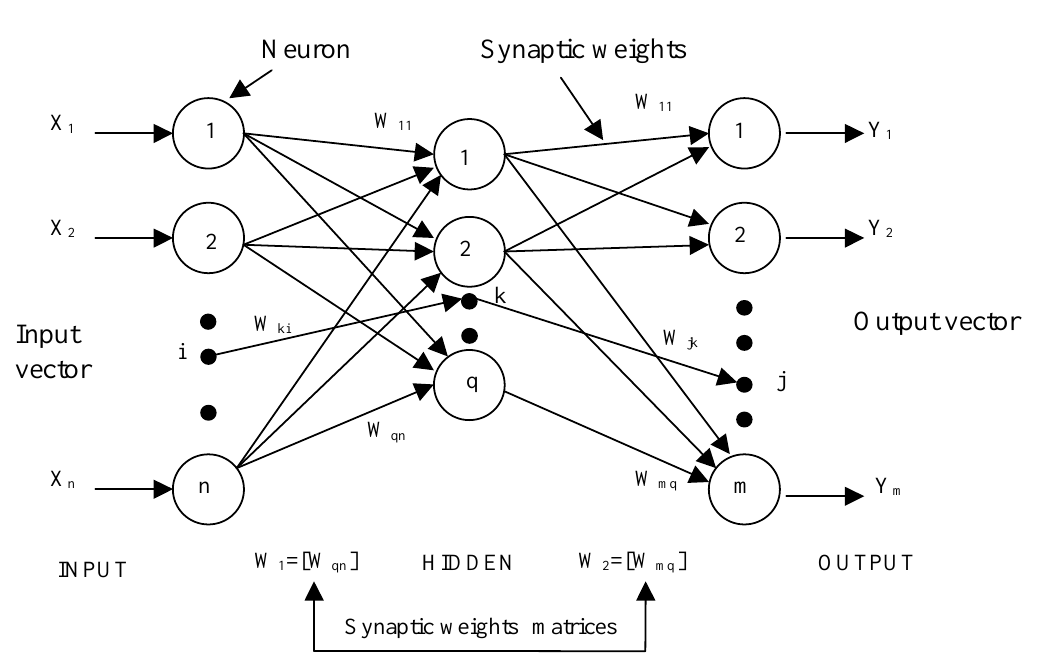
Fig. 2. Scheme of the Multi-Layer Perceptron artificial neural